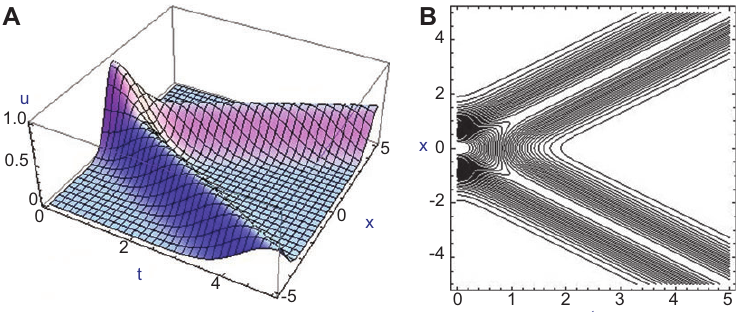
Figure 1 3D plot (A) and contours (B) of solutions of d ’ Alembert ’ s solution for the wave